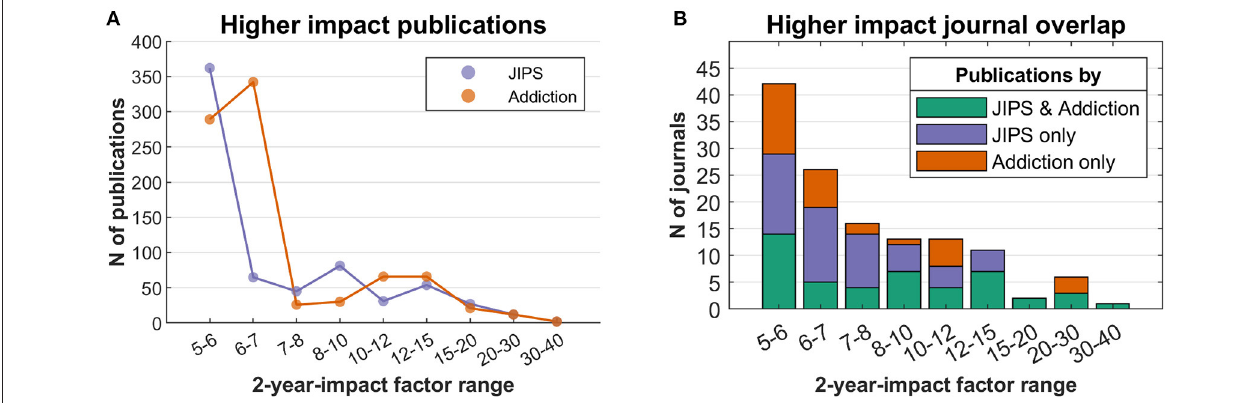
FIGURE 9 | Publications in high-impact journals in JIPS database and comparator database. (A) Number of publications in journals binned by 2-year impact factor. (B) Overlap of journals in which either database publishes its results. Stacked bars indicate shared journals (bottom), JIPS-only journals (middle) and comparator-only journals (top).